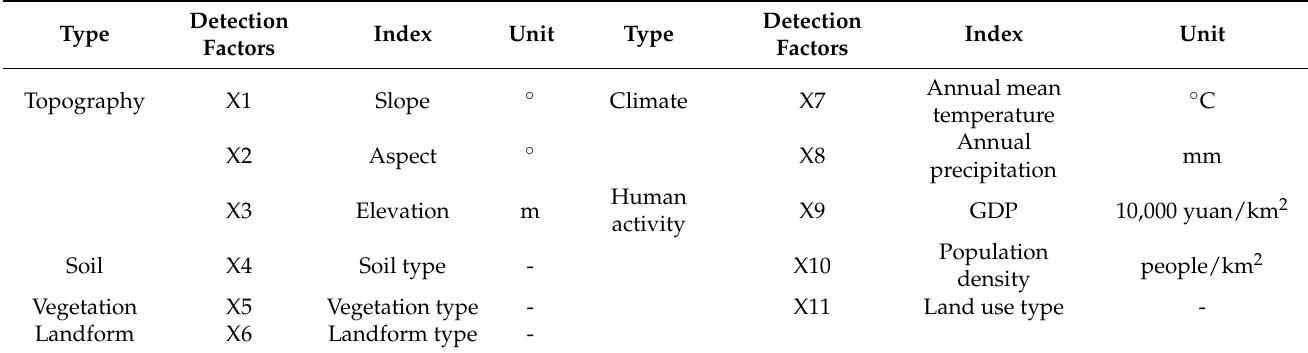
Table 1. Detection